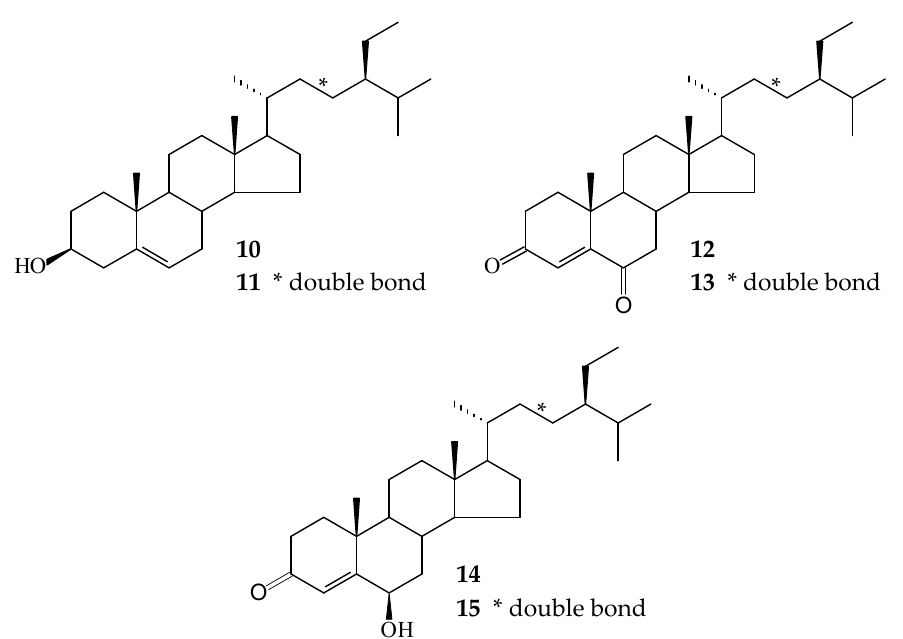
Figure 2. The chemical structures of known compounds 3 – 15 isolated from C. zedoaria .